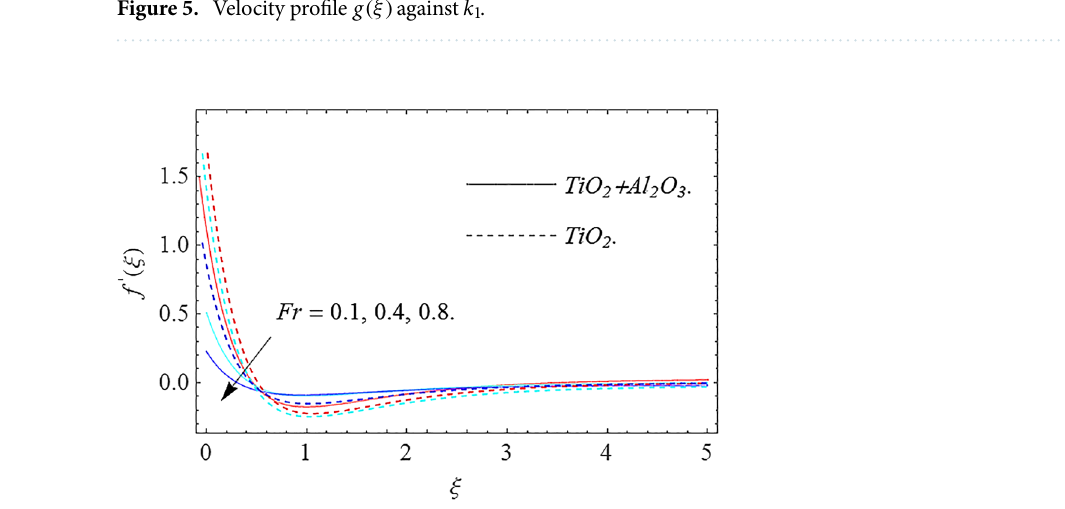
Figure 5. Velocity profile g (ξ) against k 1 .